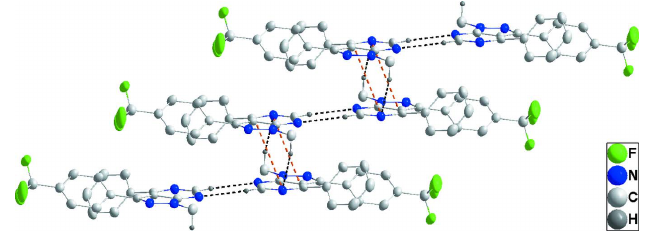
Figure 3 Packing projected along the c -axis direction giving end views of three adjacent chains. Intermolecular interactions are depicted as in Fig. 2.